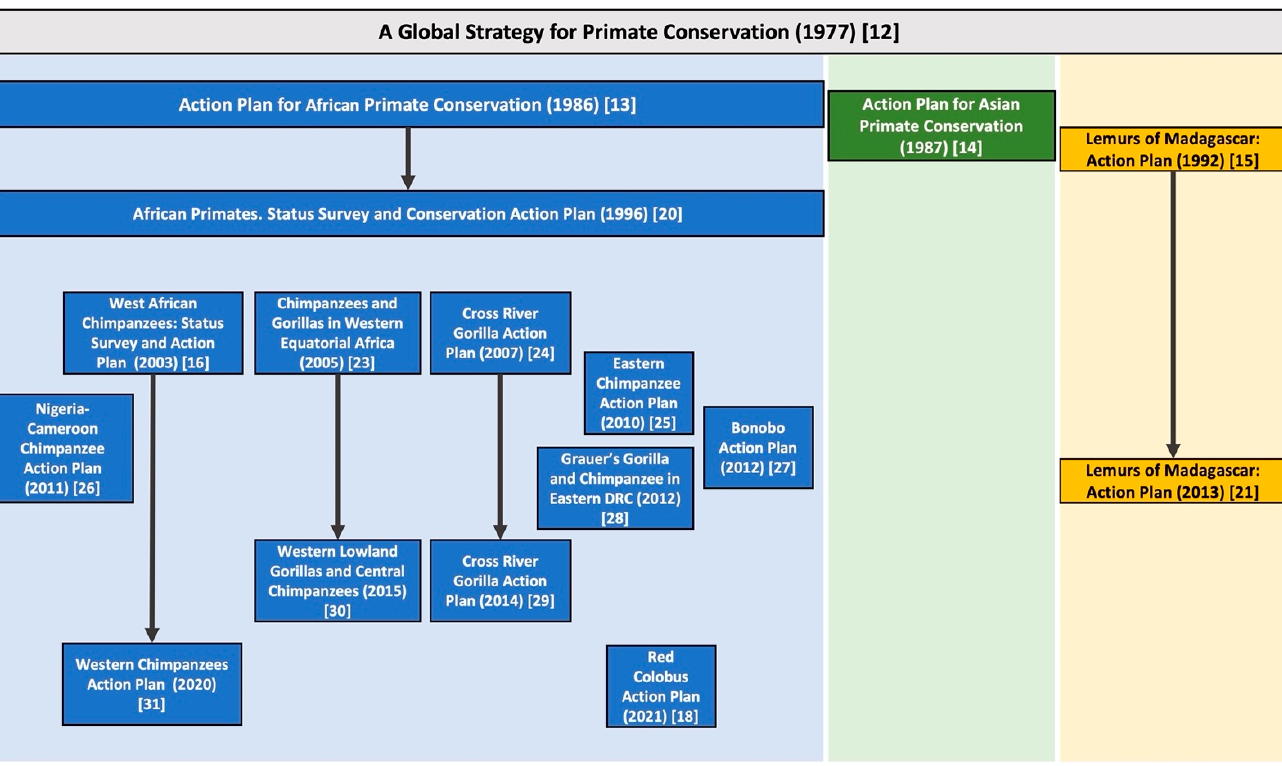
6 of 26 Figure 1. Covers of some IUCN SSC PSG primate conservation action plans. Plans pictured (top row then the bottom row, left to right): Oates [13], Eudey [14], Mittermeier et al. [15], Oates [20], Kormos et al. [16], and Schwitzer et al. [21]. It is important to note that over the last 50 years, many important and valuable primate action planning efforts have taken place outside of the direct remit of the IUCN SSC PSG (some examples are reviewed in [17]). For example, Saving the Lion Marmosets [32], was perhaps the first publication looking to establish a conservation plan for a single primate genus ( Leontopithecus ). As another example, and over the last few decades, the IUCN SSC Conservation Planning Specialist Group (CPSG; formerly Captive Breeding,